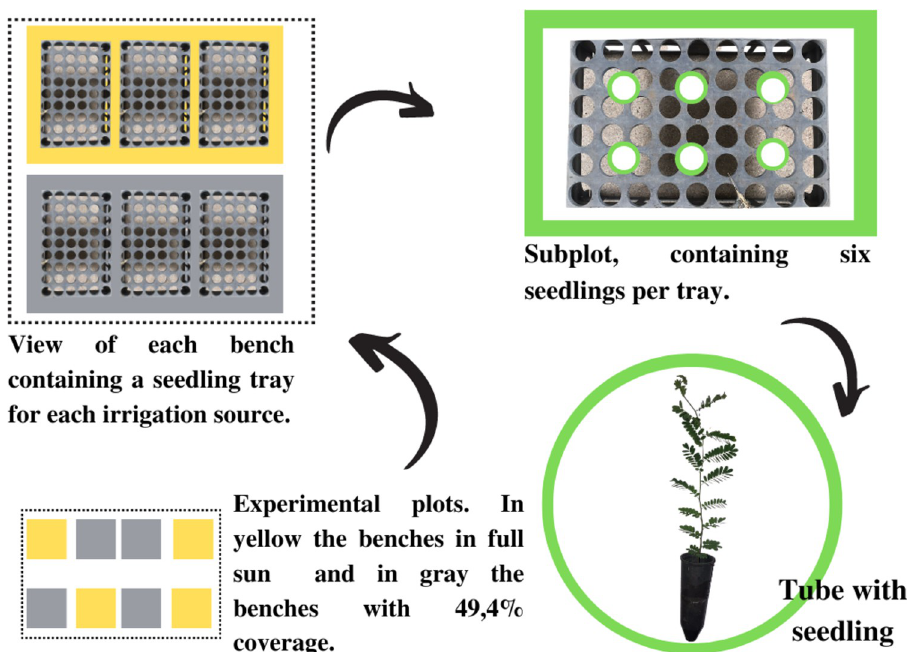
Fig 1. Experimental scheme with two covers (plot) and three types of water for irrigation